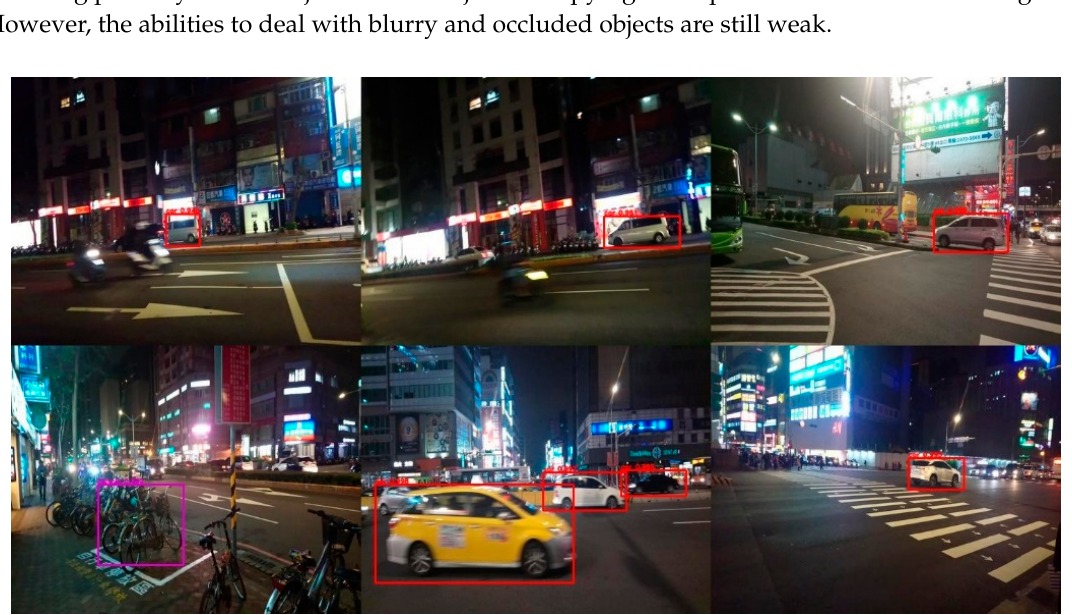
Figure 1. Urban nighttime images processed by the Faster R-CNN [5] with VGG16 [1] trained using PASCAL VOC 2007 [6].